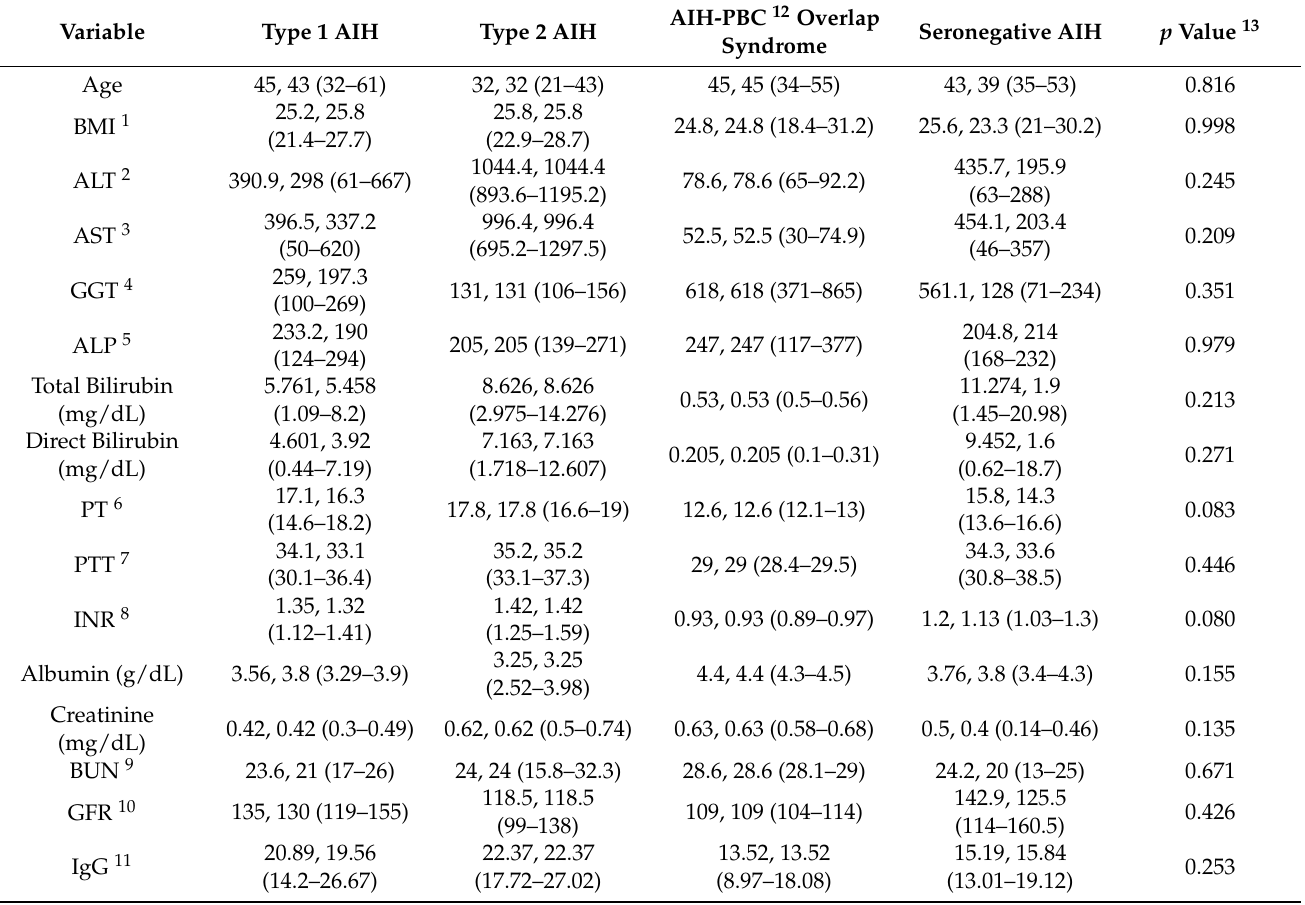
Table 1. Characteristics of the various laboratory panels at time of diagnosis stratified by autoimmune hepatitis (AIH) types in the study